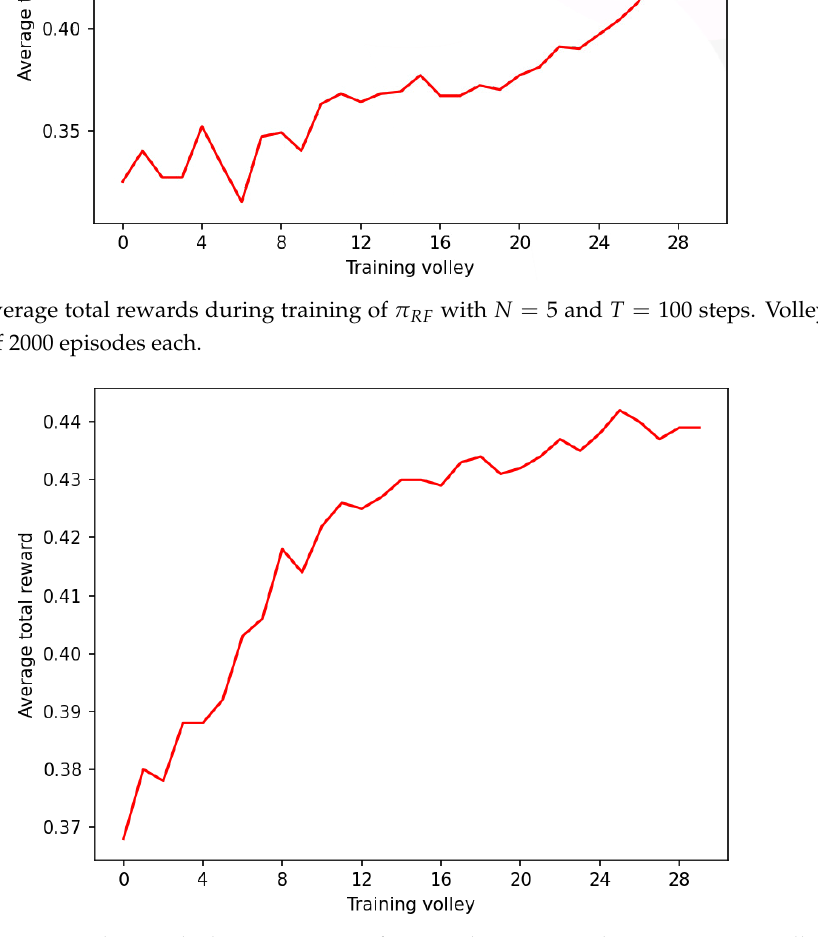
Figure 7. Average total rewards during training of π RF with N = 10 and T = 100 steps. Volleys are composed of 2000 episodes